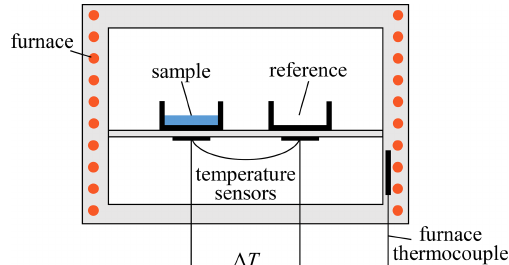
Figure 1. Setup of a conventional heat flux differential scanning calorimeter.